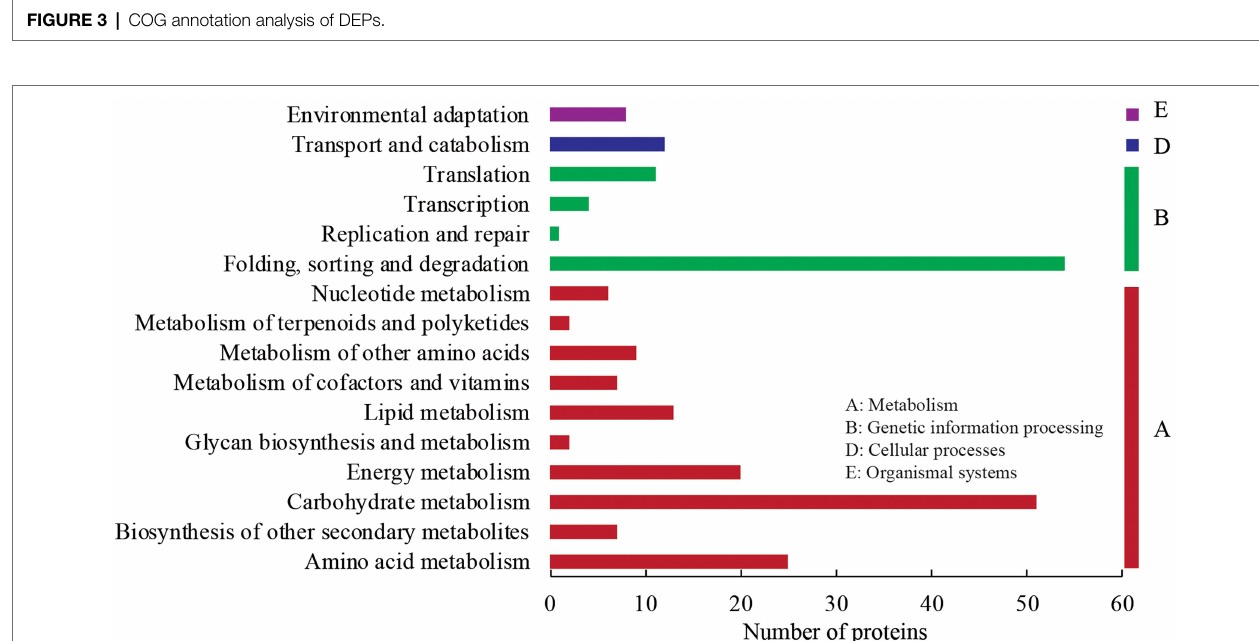
FIGURE 4 | KEGG annotation analysis of